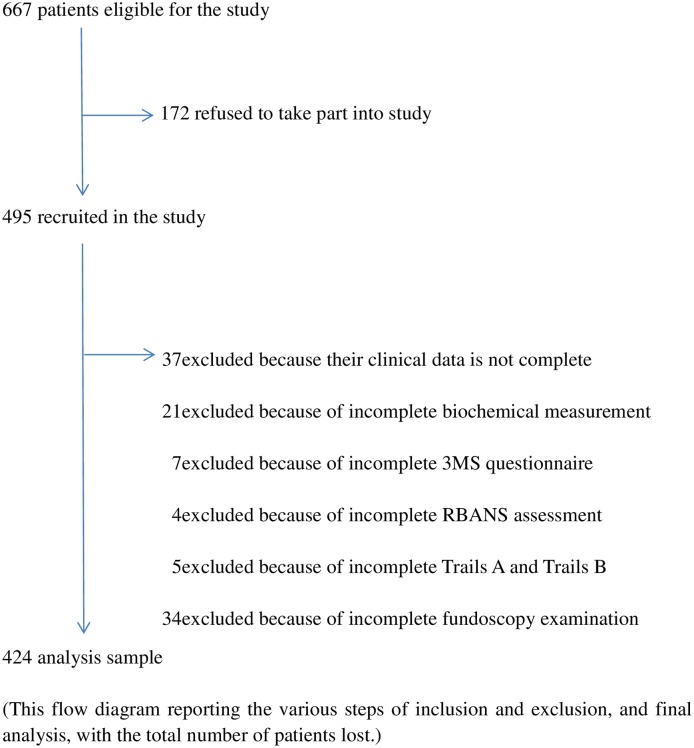
Selection and exclusion process of participants.